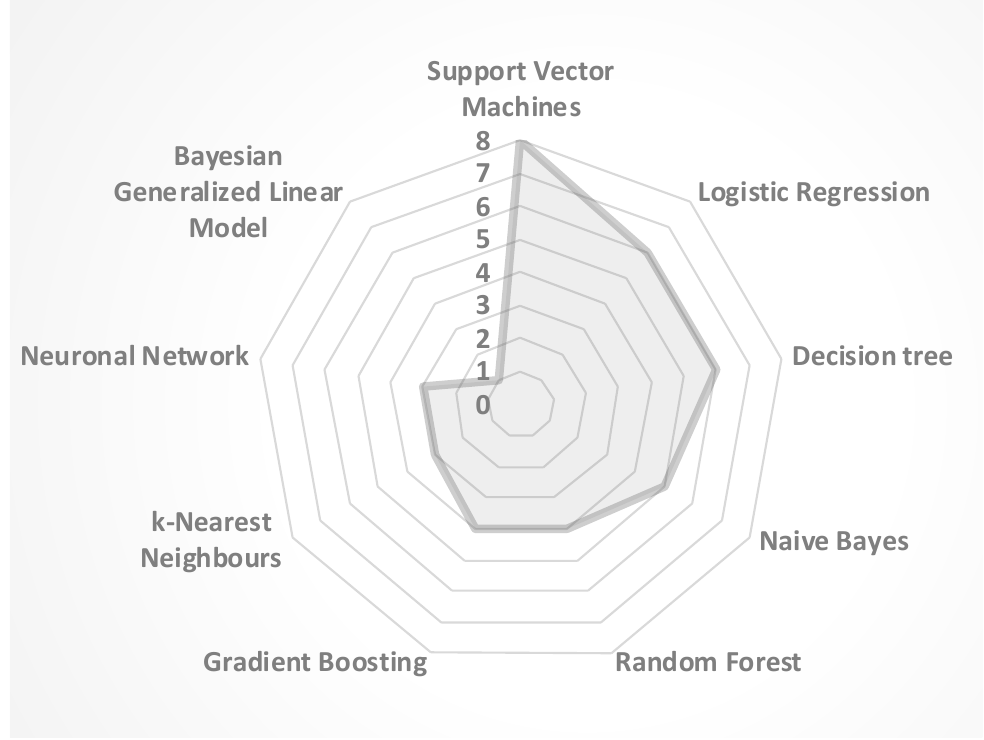
Figure 5. Algorithms used to predict students’ dropout rate in the